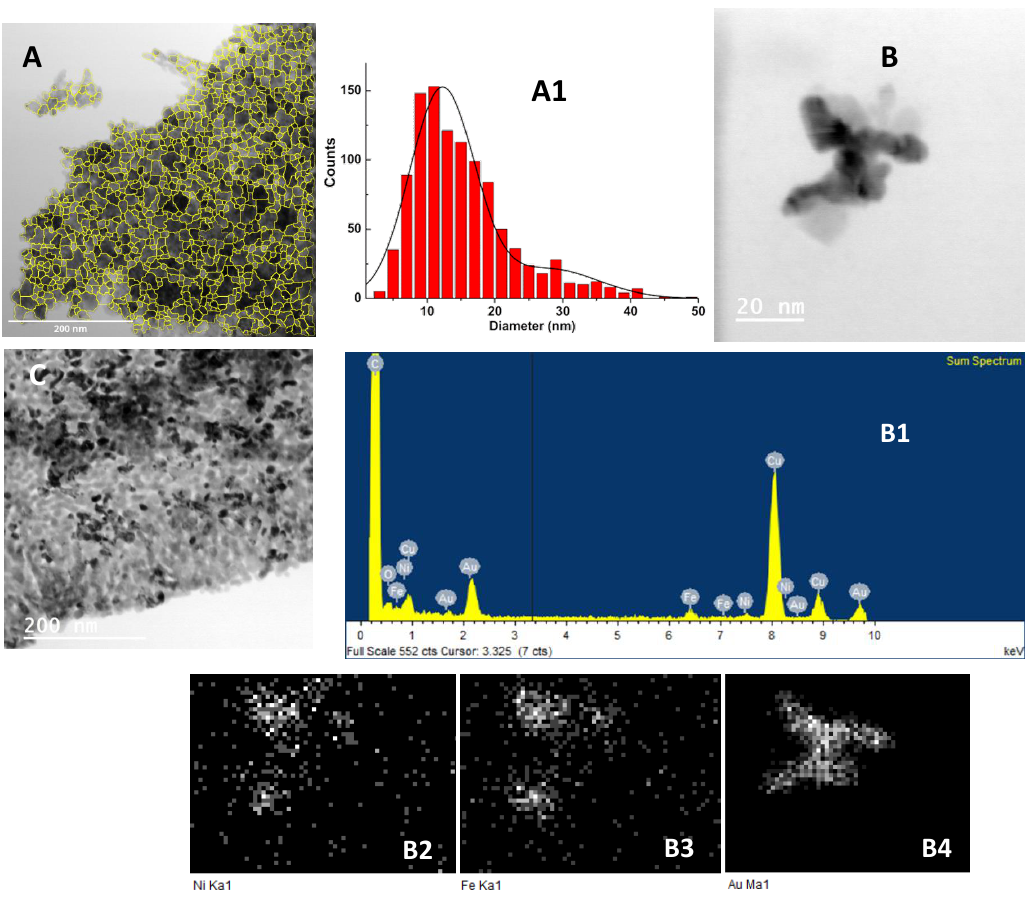
Figure 7. TEM images of the nickel ferrite/Au nanoparticles. A. Nickel ferrite nanoparticles decorated with gold nanoparticles (scale: 200 nm). A1. Size histogram of image A and fitting to a Gaussian distribution. B. Nickel ferrite nanoparticles decorated with gold nanoparticles (scale: 20 nm). B1. Electron-dispersive X-ray (EDX) spectrum of TEM image B, using Ni ( B2 ), Fe ( B3 ), and Au ( B4 ) X-ray emission lines. C. Core/shell nickel ferrite/gold nanoparticles (scale: 200 nm).